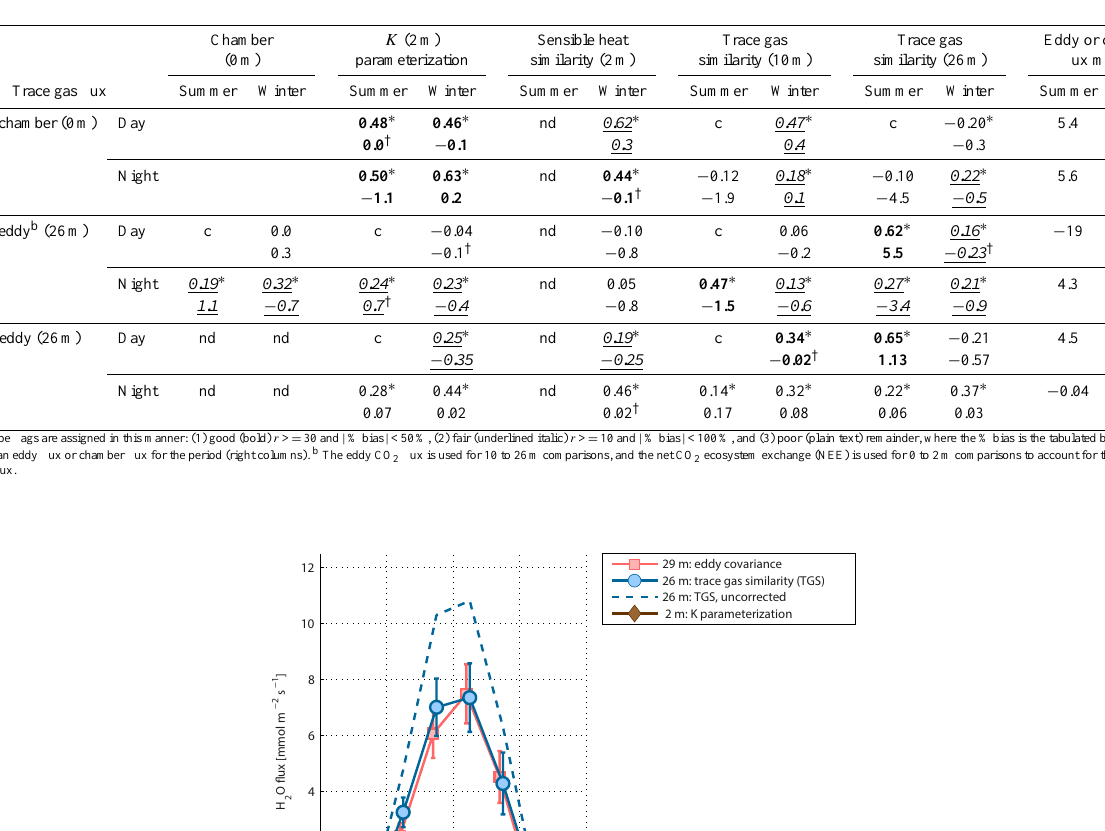
Table A1. Same as Table 2, but for uncorrected trace gas similarity fluxes (Sect. 4.2). Quantitative comparison of CO 2 and H 2 O fluxes determined by flux-gradient methods and by independent eddy covariance and chamber measurements. First, the correlation between flux method pairs ( r , Pearson’s linear correlation coefficient) is given, and statistically significant correlations are indicated by ∗ (Student’s t test, p value<0.05, α = 0 . 05). Second, the median of the bias over the period (column header minus row) is given in µmolCO 2 m − 2 s − 1 and mmol H 2 Om − 2 s − 1 , and instances when this mean bias is not significantly different from zero are indicated by † (Student’s t test, p value>0.05, α = 0 . 05). A text-type flag a is assigned to each flux-gradient method to indicate the level of performance against the indepen-